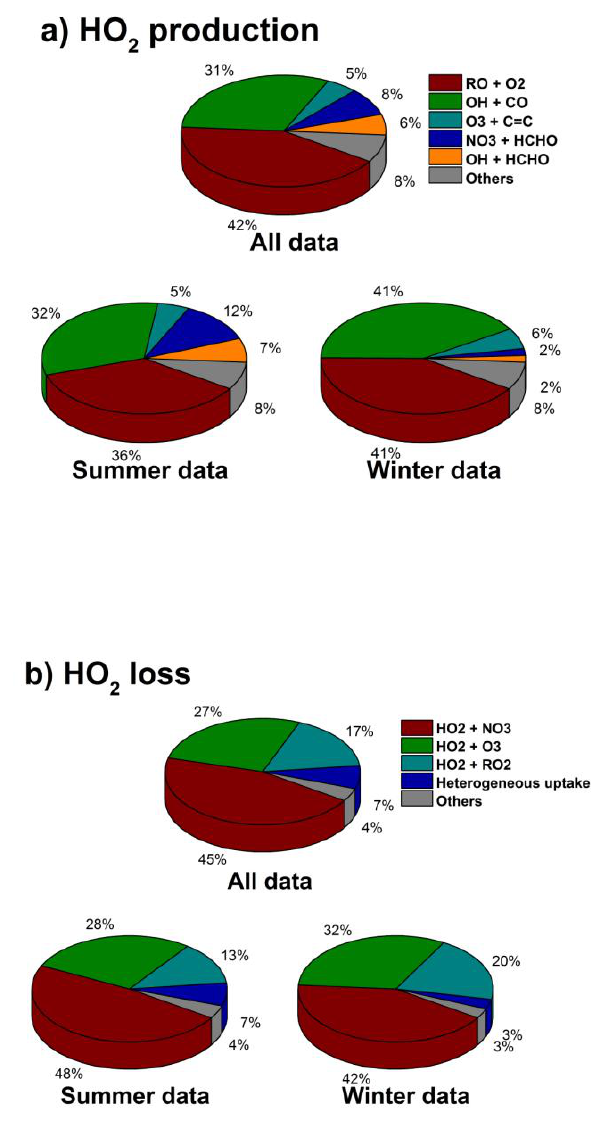
Fig. 10. Processes controlling the instantaneous production (a) and loss (b) of HO 2 radicals at night. The upper panels show the sum- mer and winter campaign means combined, with the lower panels showing the summer campaign means (left hand side) and winter Figure 10: Processes controlling the instantaneous production (a) and loss (b) of HO campaign means (right hand side). The average total production rate of HO 2 was (9.3 ± 5.6) × 10 4 cm − 3 s − 1 (median = 7.9 × 10 4 The upper panels show the summer and winter campaign means combined, with the lower panels cm − 3 s − 1 ) for the entire data set, (9.8 ± 6.7) × 10 4 cm − 3 s − 1 showing the summer campaign means (left hand side) and winter campaign means (right hand side). (median = 7.9 × 10 4 cm − 3 s − 1 ) for the summer campaign and (8.5 ± 3.1) × 10 4 cm − 3 s − 1 (median = 7.9 × 10 4 cm − 3 s − 1 ) for the winter campaign. The average total loss rate of HO 2 was (9.4 ± 5.8) × 10 4 cm − 3 s − 1 (median = 8.1 × 10 4 cm − 3 s − 1 ) for the entire data set, (9.9 ± 7.0) × 10 4 cm − 3 s − 1 (median = 8.0 × 10 4 cm − 3 s − 1 ) for the summer campaign and (8.8 ± 3.2) × 10 4 cm − 3 s − 1 (median = 8.2 × 10 4 cm − 3 s − 1 ) for the winter cam- paign.